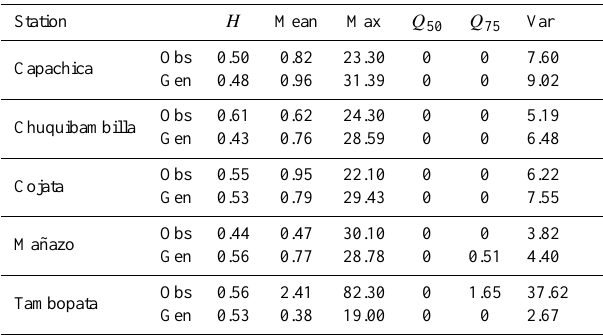
Table 7. Statistics of temporal information during the dry season